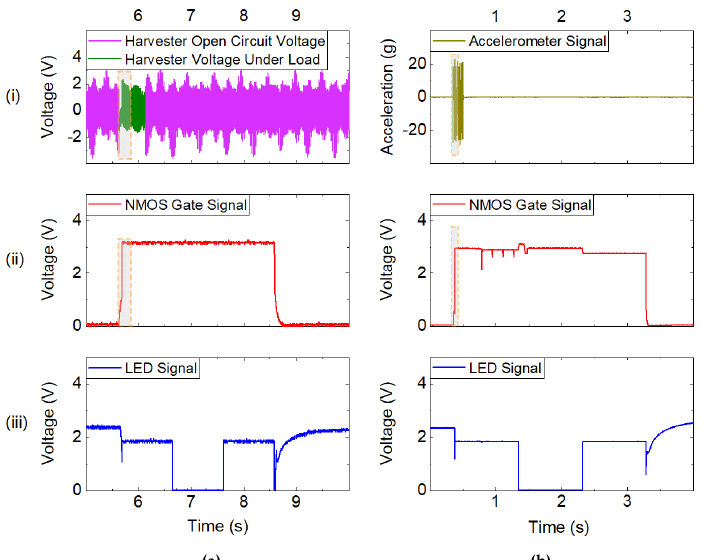
Figure 9. Wakeup of a microcontroller with subsequent program execution: ( a ) with contactless magnetic excitation of the harvester; ( b ) wakeup with mechanical excitation. The wakeup processes in the dashed sections are displayed in more detail in Figure 10.